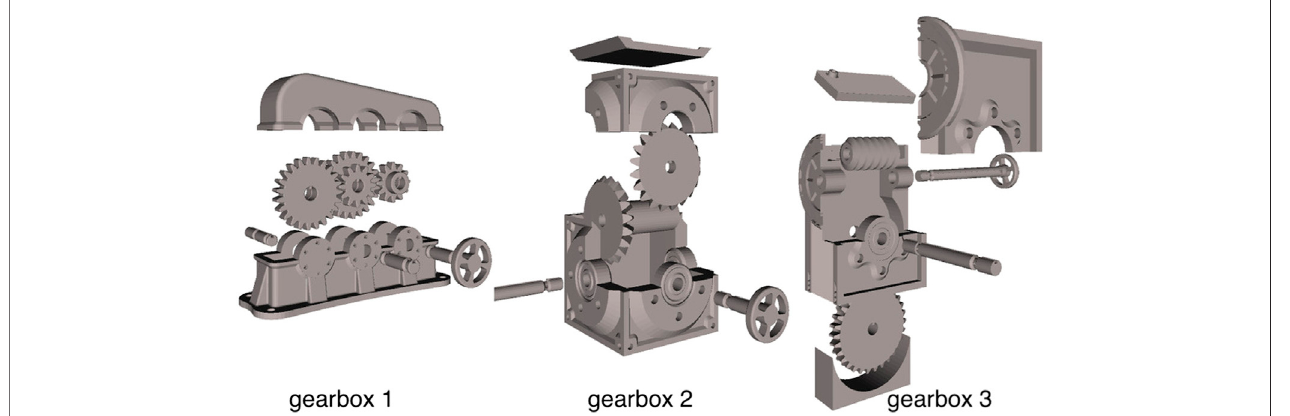
FIGURE 3 | Exploded view of the three gearboxes.